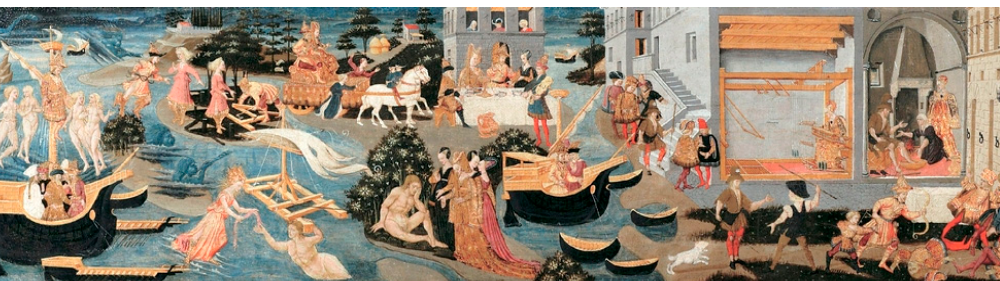
Figure 2. Apollonio di Giovanni, The Adventures of Odysseus (1430–40), cassone front, tempera on panel, by permission of Kraków, Royal Wawel Castle.